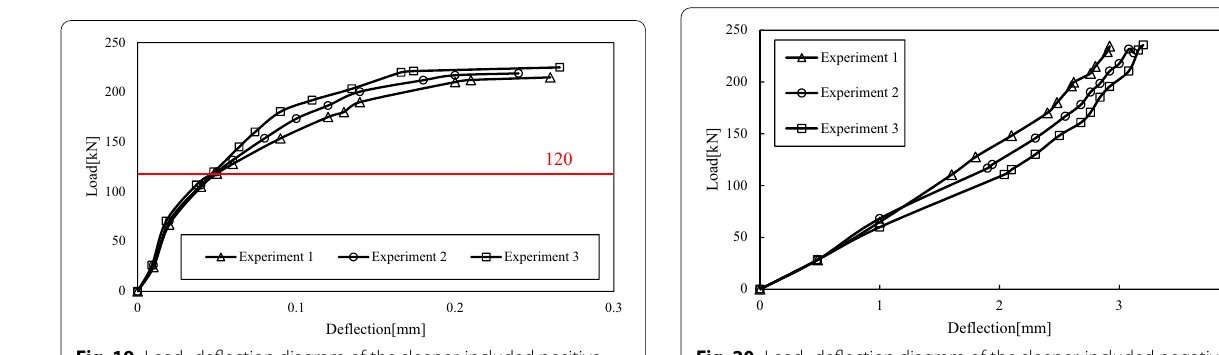
Fig. 19 Load–deflection diagram of the sleeper-included positive bending moment of the rail seat.